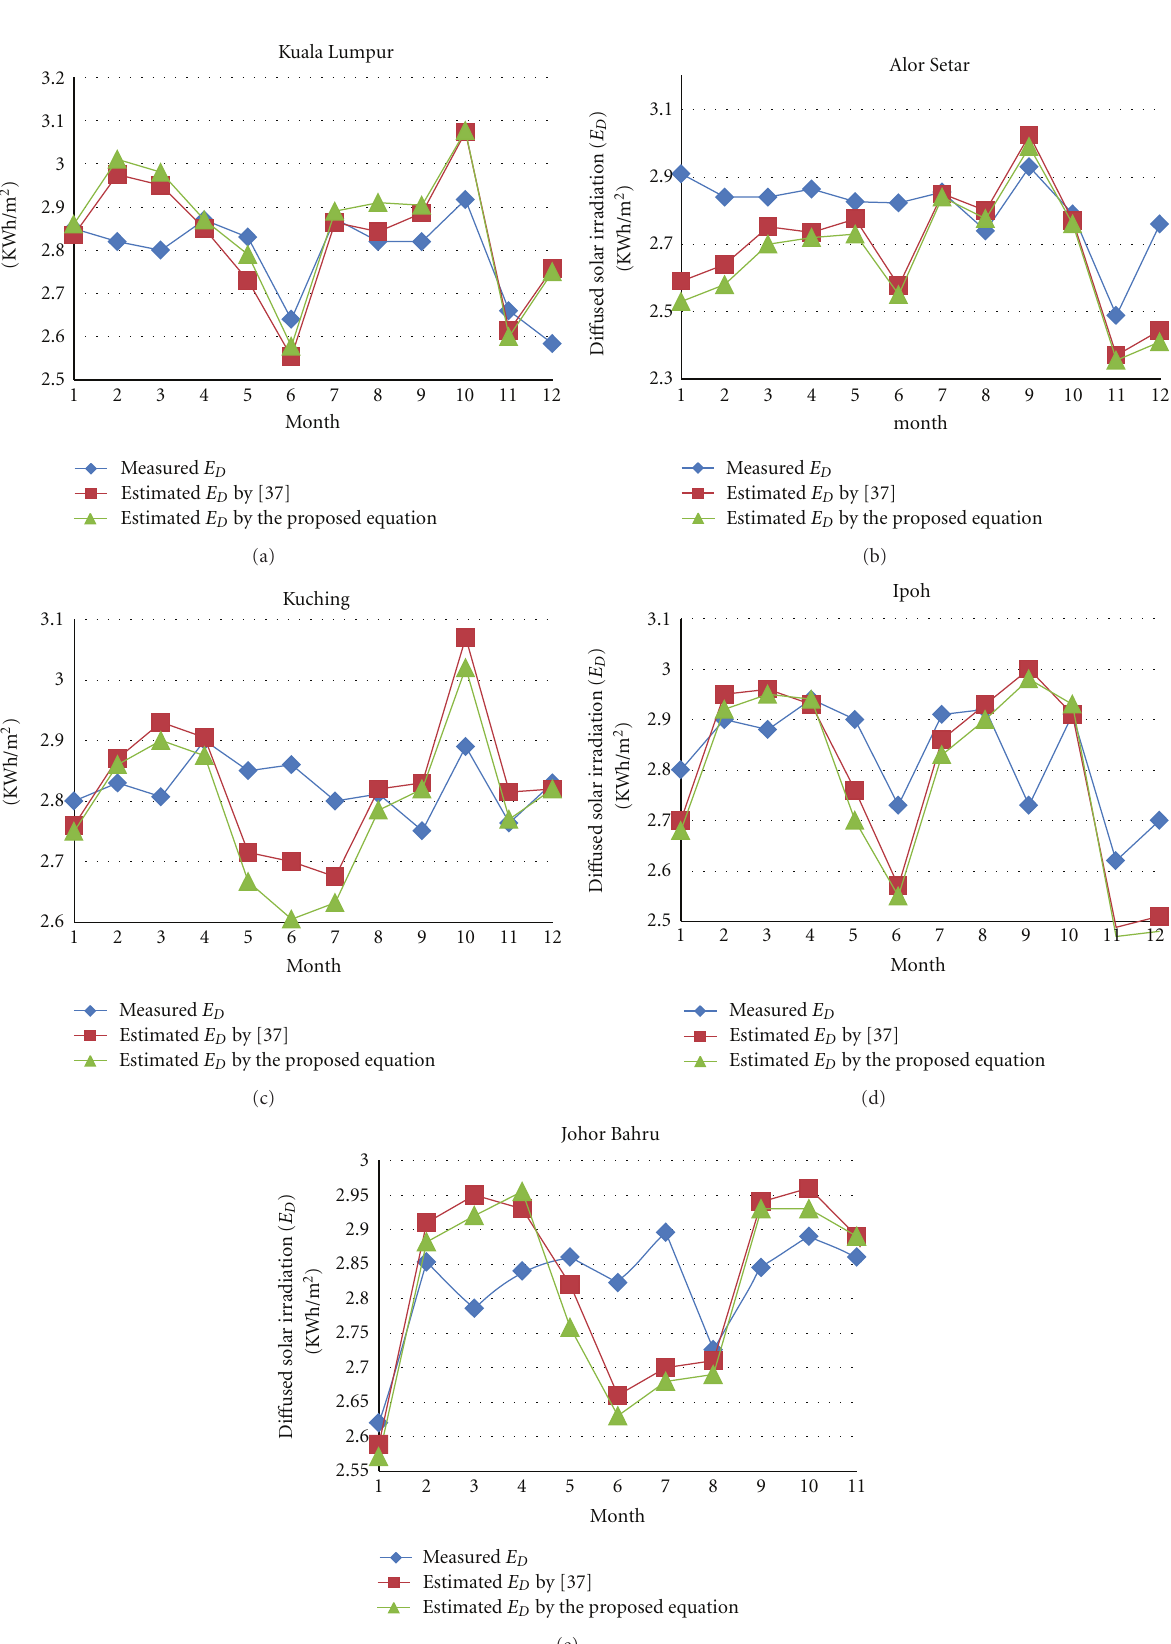
Figure 9: Comparison between the monthly average of the predicted and the measured di ff used solar